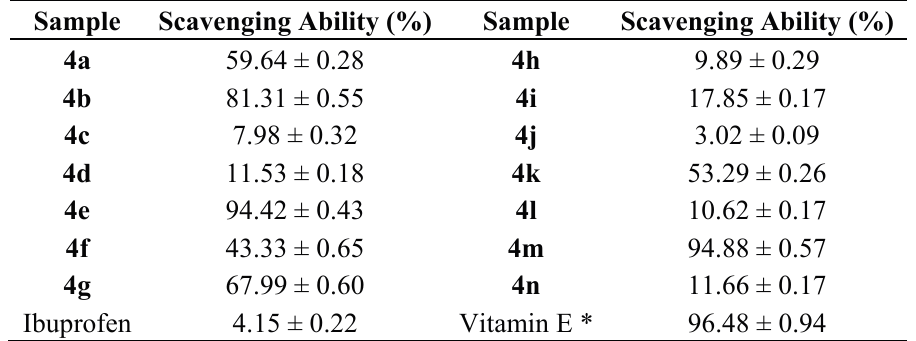
Table 5. The DPPH radical scavenging ability of the thiazolidine-4-one derivatives 4a – n